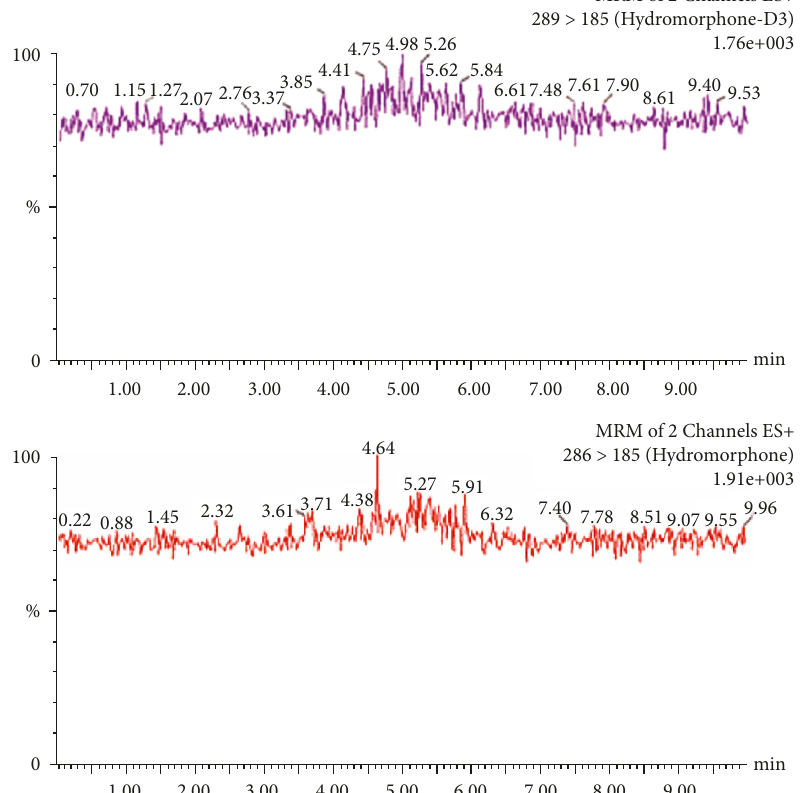
Figure 1: Chromatogram of a blank sample (blank plasma plus internal standard). The internal standard hydromorphone-D3 is presented in the upper panel and hydromorphone in the lower panel, respectively.